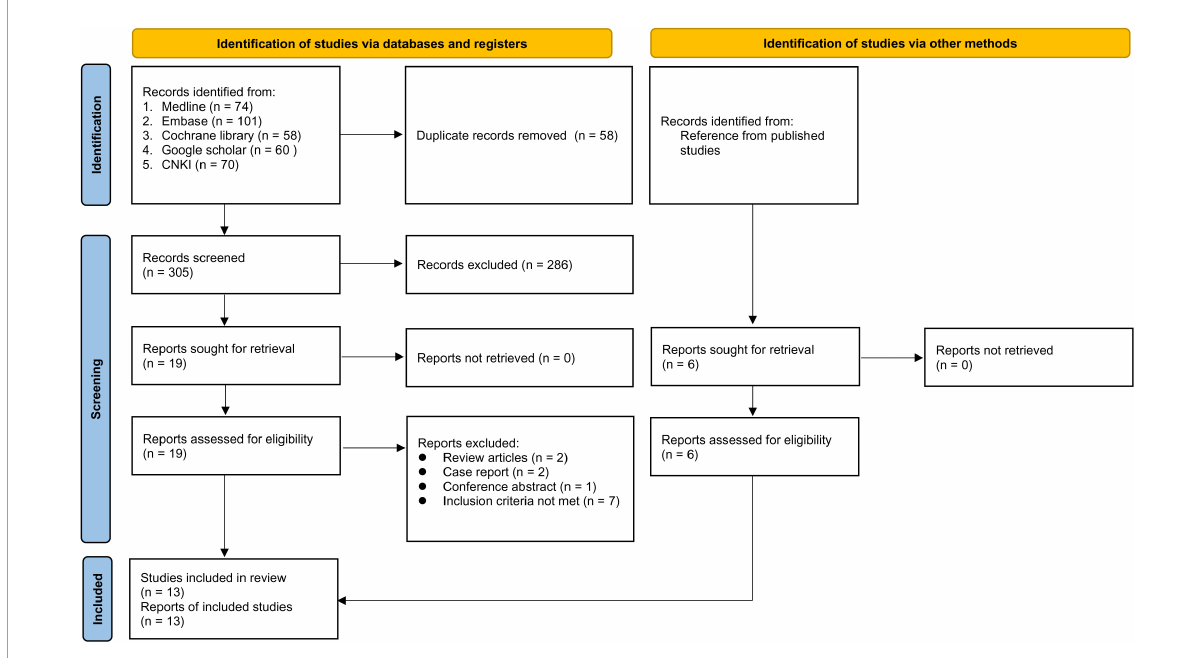
FIGURE1 Flow diagram of study selection for the current